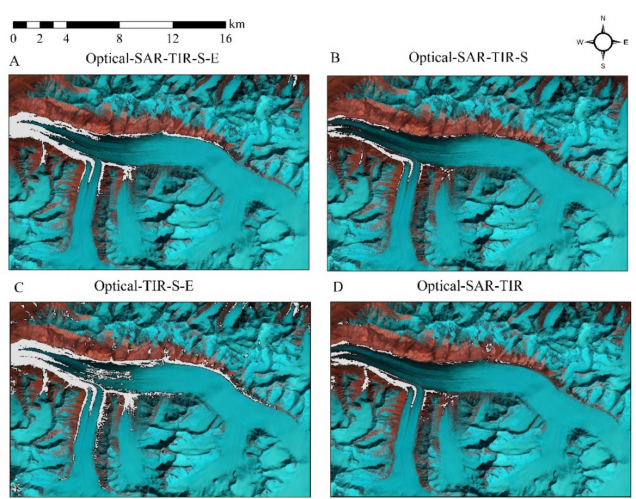
Figure 10. Qualitative analysis of results obtained using different combinations of bands. ( A ) Optical- SAR-TIR-S-E (blue, green, red, NIR, SWIR, coherence, slope, and elevation), ( B ) Optical-SAR-TIR-S (blue, green, red, NIR, SWIR, coherence, and slope), ( C ) Optical-TIR-S-E (blue, green, red, NIR, SWIR, and slope), ( D ) Optical-SAR-TIR (blue, green, red, NIR, SWIR, SAR, and TIR). The classification results obtained from the Optical-SAR-TIR-S-E layer showed better discrimination of SGD from